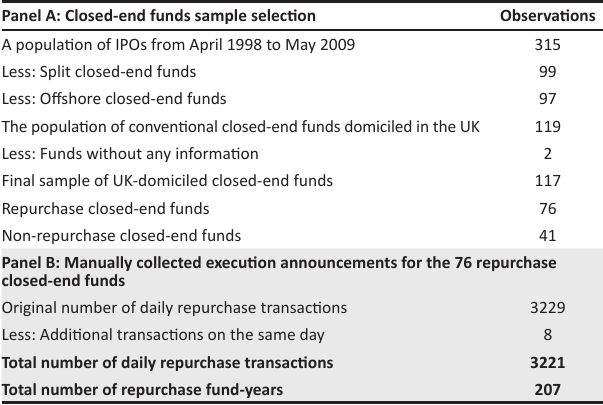
TABLE 2: Data and sample